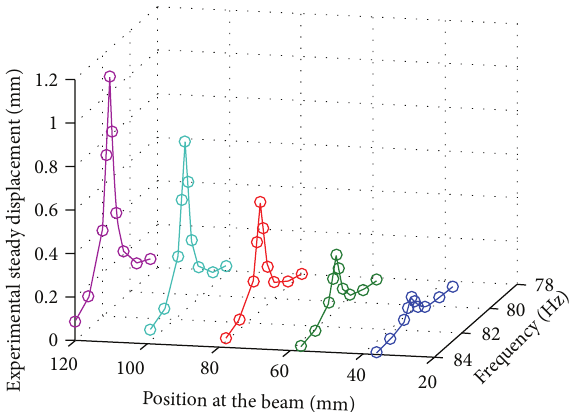
Figure 16: Experimental steady-displacement responses versus positions and